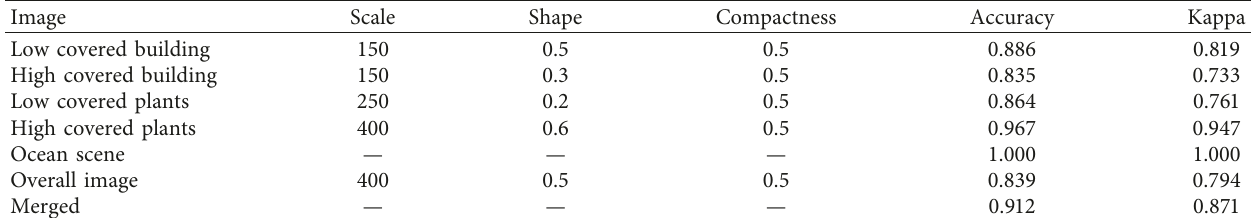
Table 5: The optimal segmentation parameters and classification results for different scenes of image A.